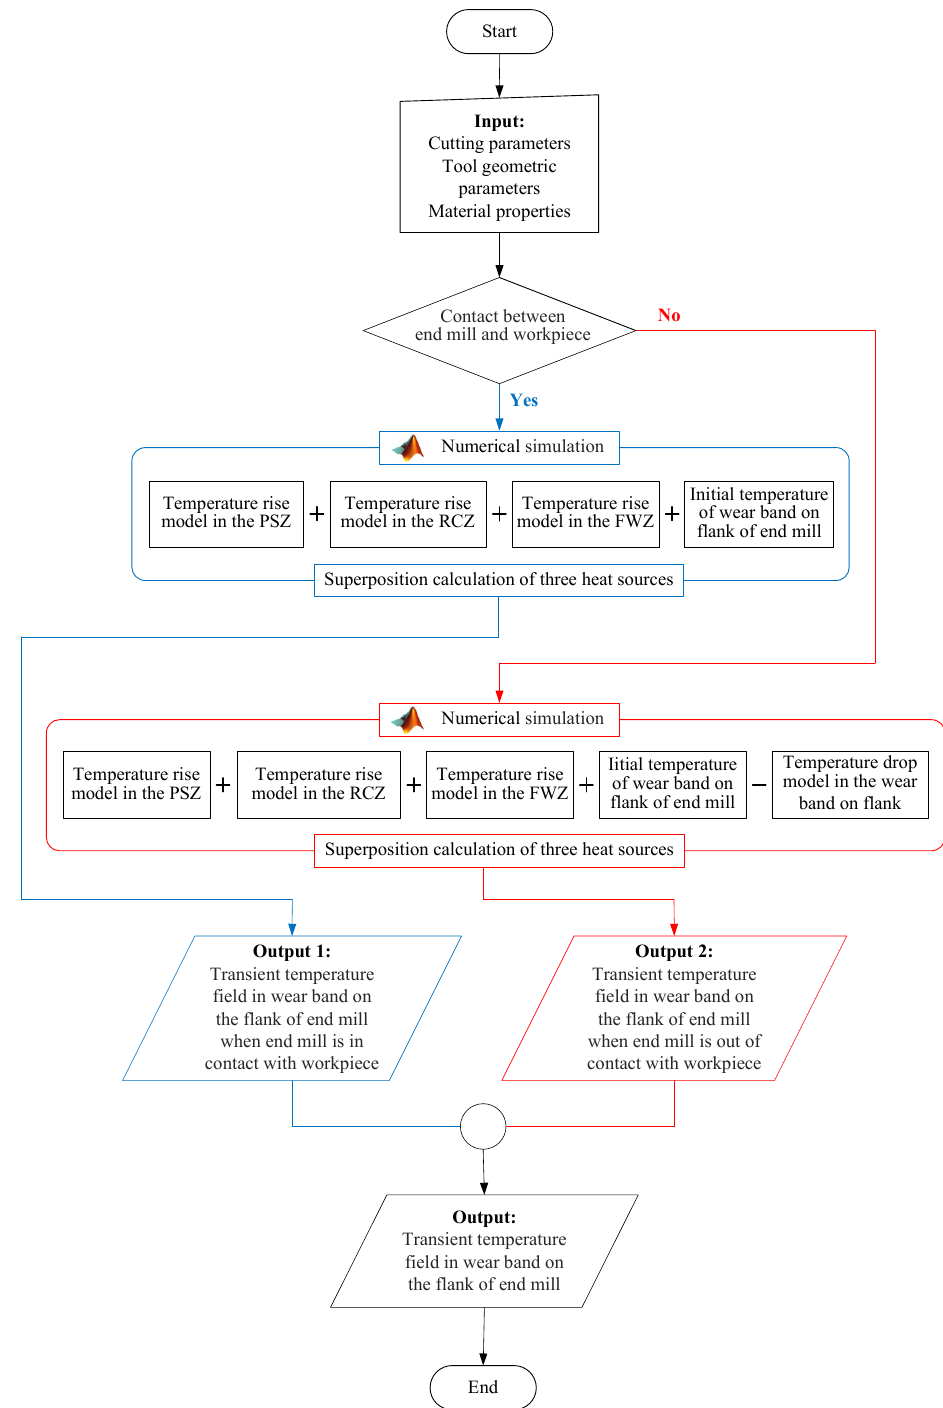
Figure 10. Modelling flow chart for the transient temperature field of wear band on the flank of end